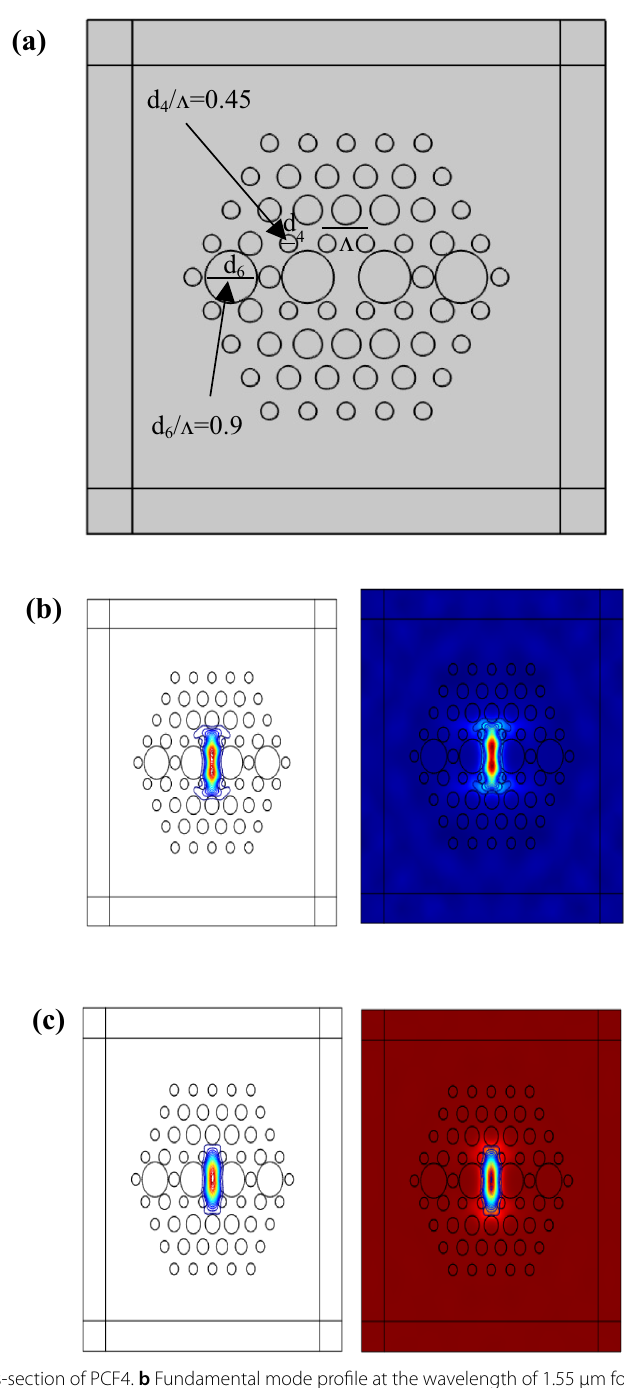
Fig. 4 a Cross-section of PCF4. b Fundamental mode profile at the wavelength of 1.55 µm for X -polarisation mode. c Fundamental mode profile at the wavelength of 1.55 µm for Y -polarisation